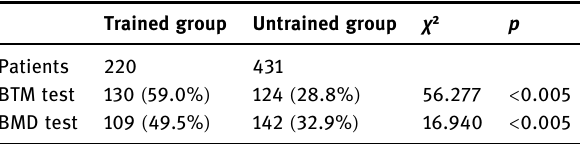
Table 1: Comparison of rate of BTMs and BMD between the trained group and untrained group [ n , ( % )] Trained group